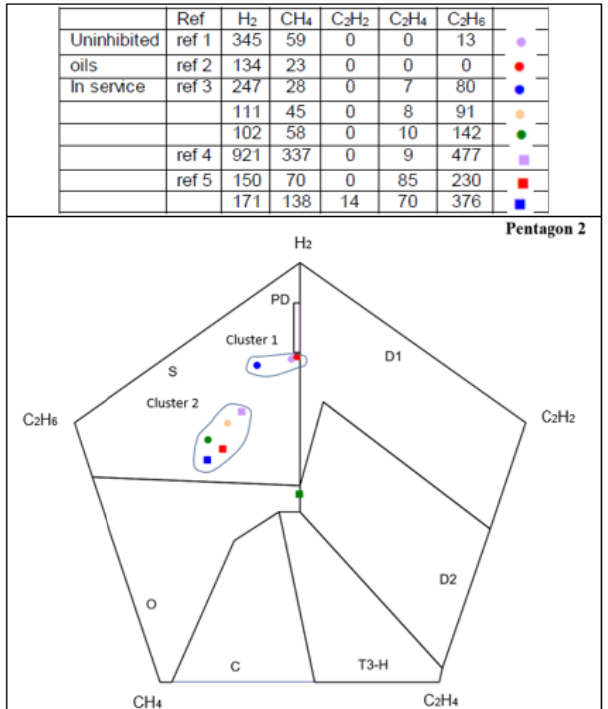
Figure 9. SG of uninhibited mineral oils other than oil B in transformers other than those from the FKH, in Clusters 1 and 2.